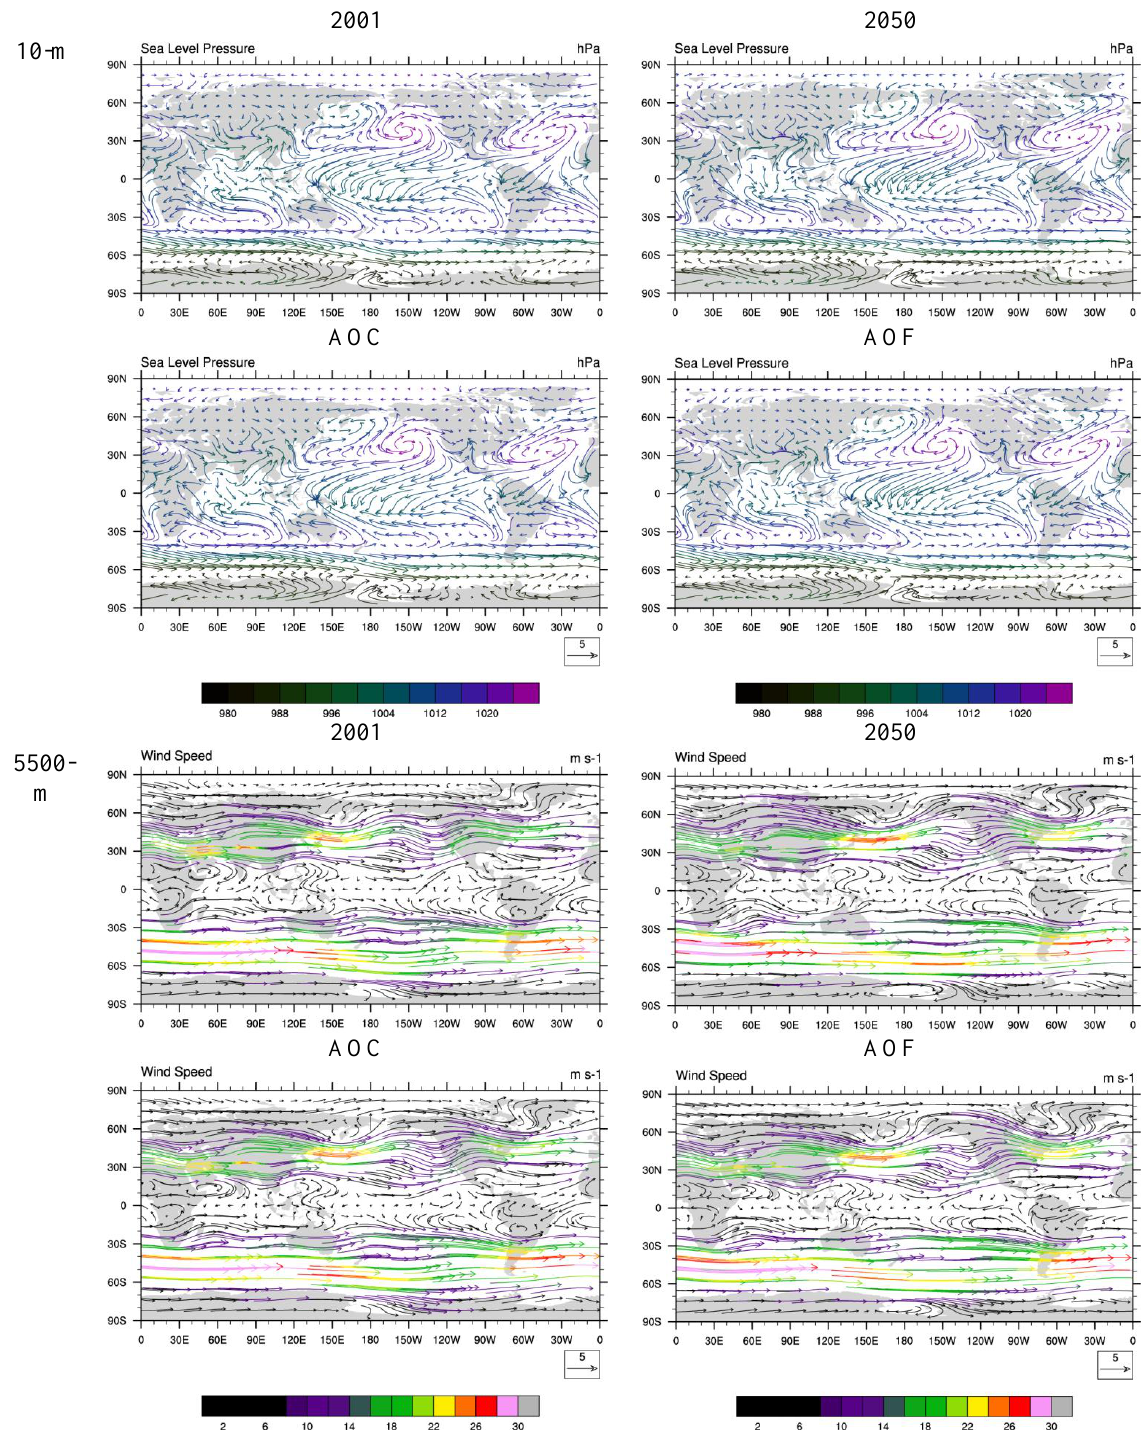
Figure 5. The average spring (MAM) weather patterns at the surface (top) and 5500 m (bottom) for 2001 and the average current period (left), 2050 and the average future period (right) from the baseline simulations. The surface plots depict the wind vectors from the 10 m wind components and the color scale is based on the sea level pressure. The 5500 m vectors are derived from the wind components interpolated to that height and the color scale is the magnitude of the wind speed.